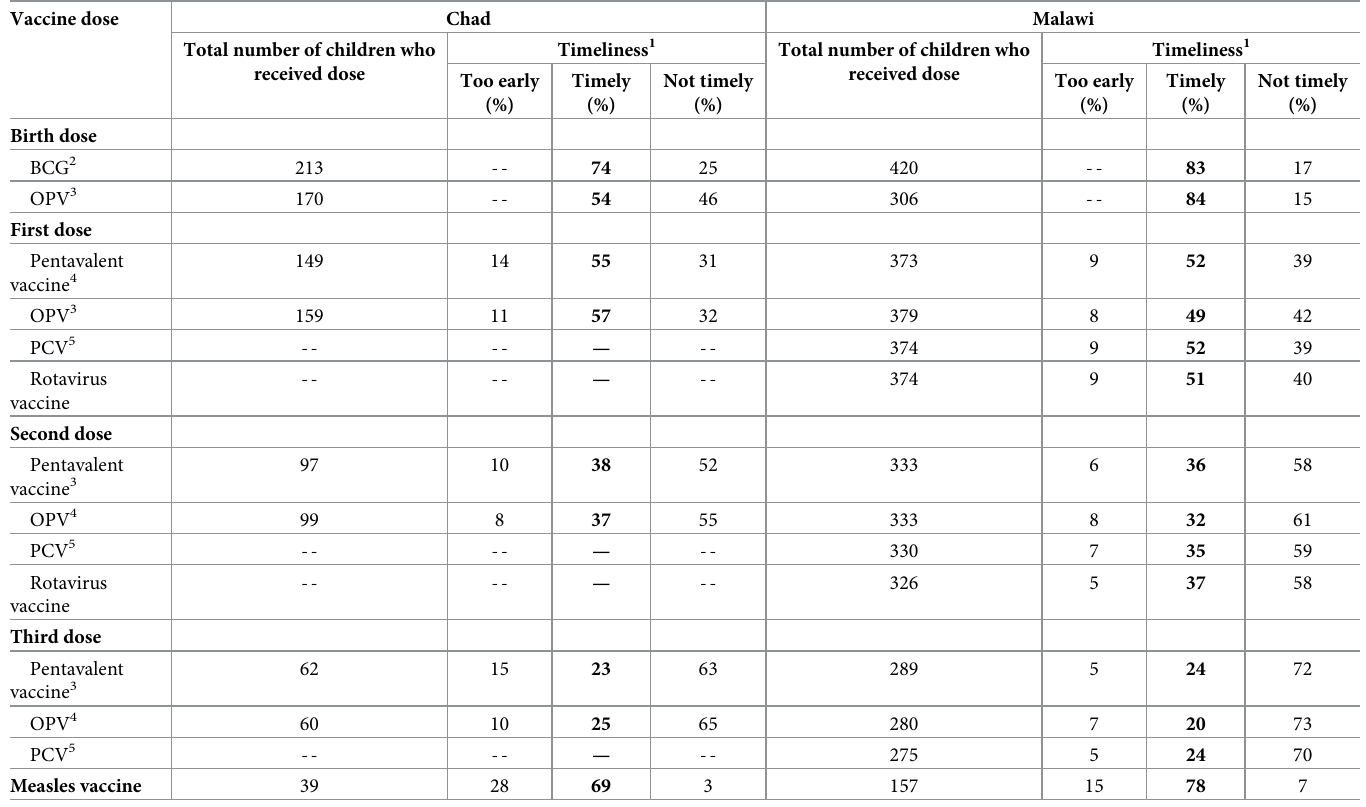
Table 5. Timeliness of vaccine doses administered to surveyed children with documented vaccination history by vaccine: Chad and Malawi, 2015. Vaccine dose Chad